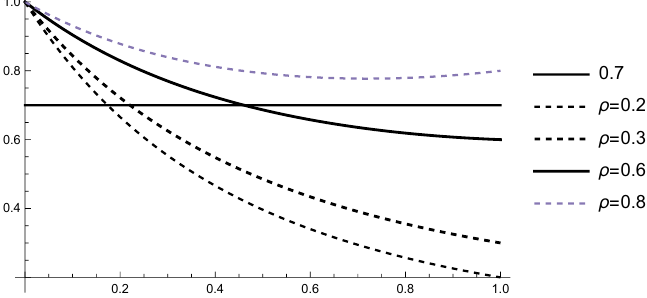
Figure 2. Graph of ρ α Γ ( 1 + α ) for various ρ and the lower bound